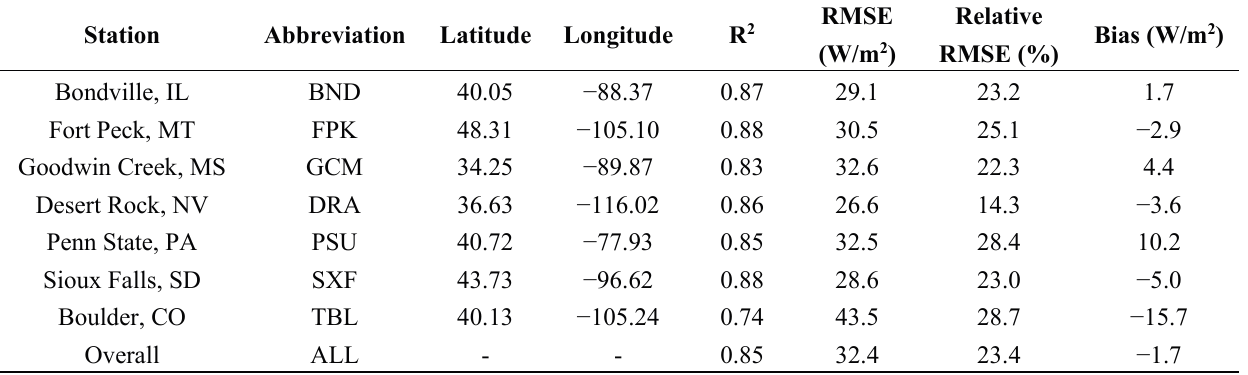
Figure 3. Scatter plot between daily SSNR measured at SURFRAD stations and that retrieved from MERSI and aggregated to the spatial resolution of 161 km. Table 3. Summary of validation results of daily SSNR retrieved from MERSI and aggregated to 161 km over SUFRAD